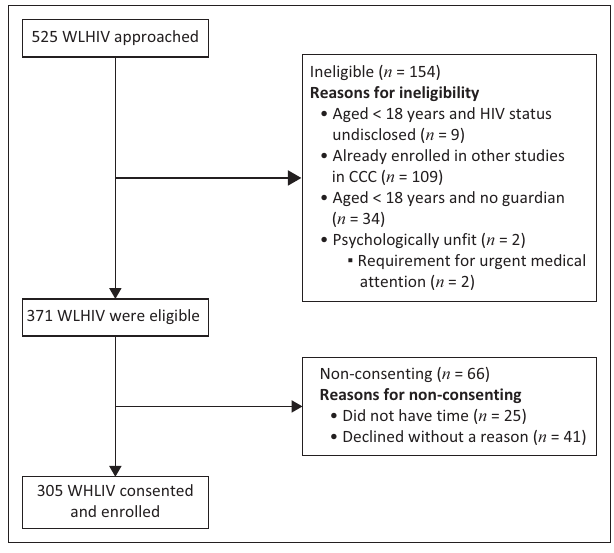
FIGURE 1: Flow diagram of the enrolment